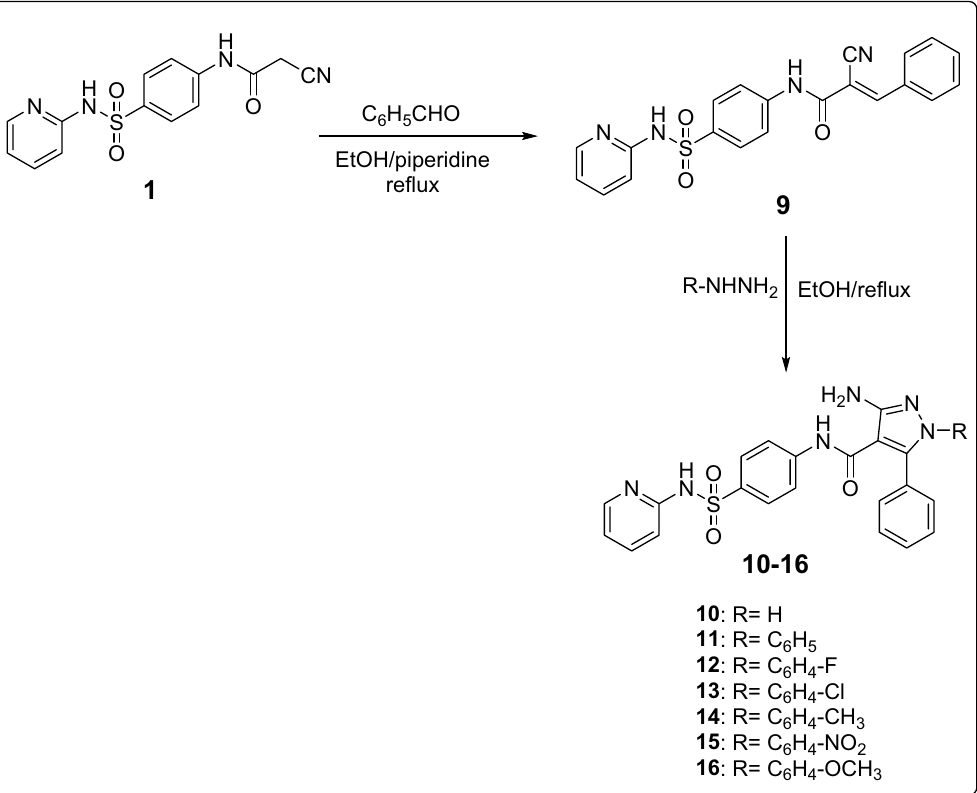
Figure 5. Synthetic route for compounds 9–16